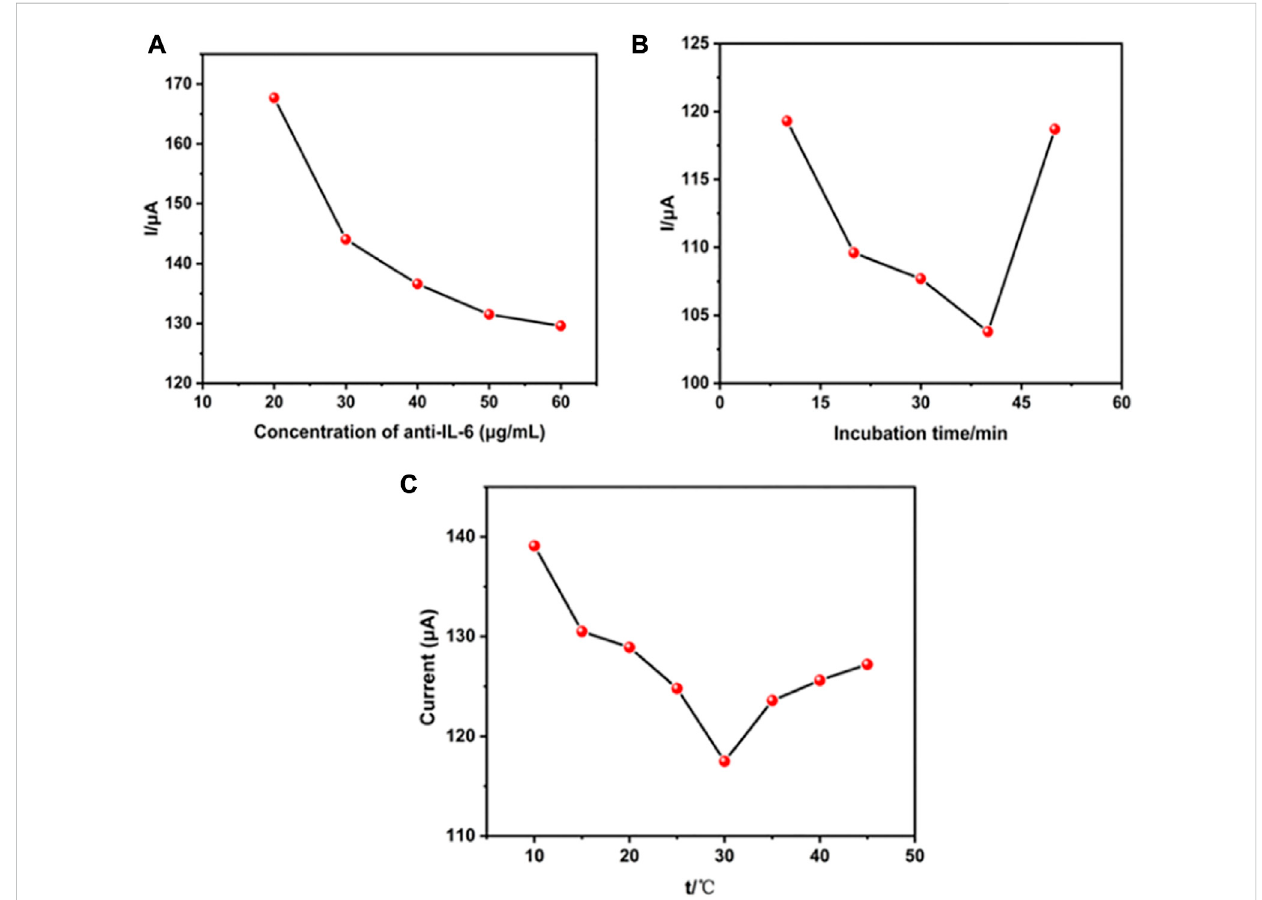
Effect of the experimental parameters. (A) The concentration of anti-IL-6 on the electrochemical immunosensor, (B) the incubation time and (C) incubation